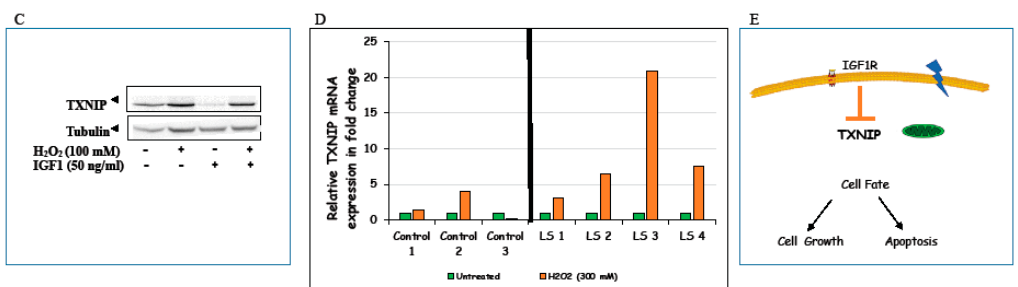
Figure 4. Regulation of thioredoxin-interacting protein (TXNIP) expression and action by IGF1. ( A ) Expression of TXNIP in LS cells. Total RNA was extracted from LS-derived and control lymphoblastoid cells and TXNIP mRNA levels were measured by RT-QPCR. ( B ) E ff ect of IGF1 / insulin on TXNIP levels. HEK293 cells were starved for 24 h, after which they were treated with IGF1 or insulin (50 ng / mL) for 5 or 12 h. TXNIP levels were then measured by Western blots. ( C ) E ff ect of oxidative stress on TXNIP levels. Serum-starved HEK293 cells were treated with H 2 O 2 (100 mM) or IGF1 or both for 2 h, after which TXNIP levels were measured by Western blots. ( D ) E ff ect of oxidative stress on TXNIP levels in LS-derived and control lymphoblastoid cell lines. Four individual LS-derived and three control lymphoblastoid cell lines were treated with 300 mM of H 2 O 2 or left unstimulated. Cells were harvested after 2 h and levels of TXNIP mRNA were measured by RT-QPCR. A value of 1 was given to TXNIP mRNA levels in untreated cells (green bars). ( E ) Schematic representation of the regulation of TXNIP expression by IGF1. TXNIP is a metabolic gene that functions as an oxidative and glucose sensor. TXNIP mRNA levels were more than two-fold higher in LS-derived lymphoblastoid cells than in healthy control cells. IGF1 was shown to exert its anti-apoptotic e ff ect via downregulation of TXNIP expression. Part of the data shown here was originally reported in